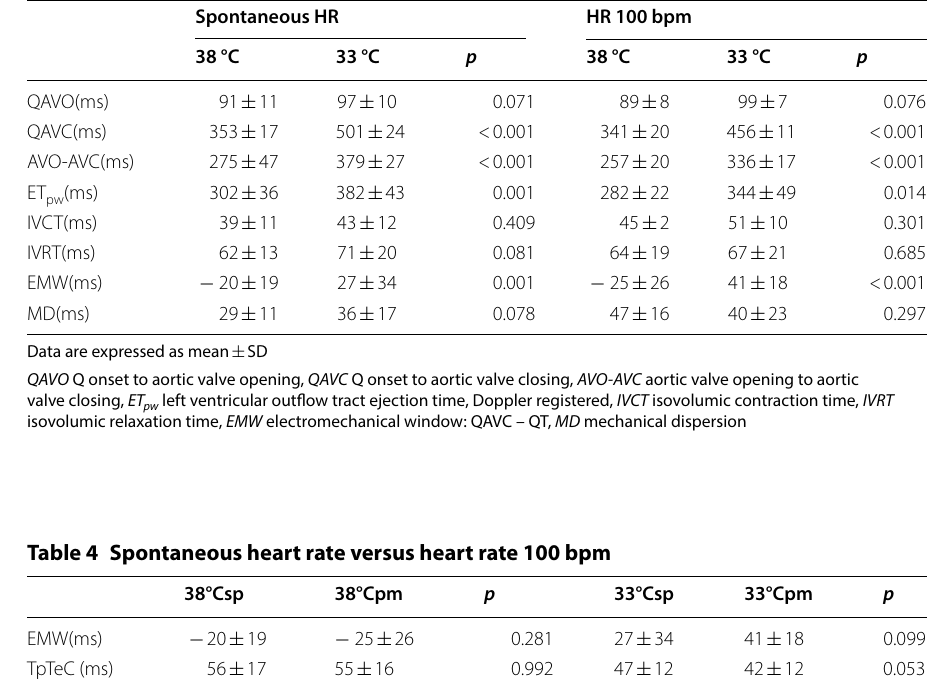
Table 3 Mechanical and electromechanical variables